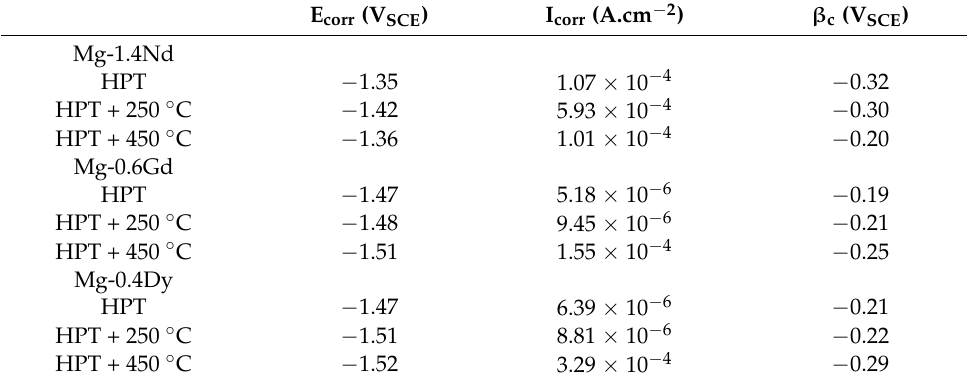
Table 1. E corr , I corr , and β c fitted from the polarisation curves of Mg–RE samples. E corr (V SCE ) I corr (A.cm − 2 ) β c (V SCE